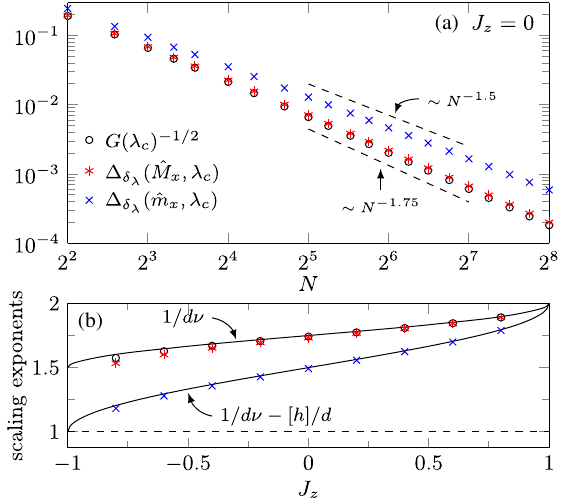
¼ 0 , z=d ¼ 1 and z ˆ M , as described by the x ð ˆ M ; λ ; t Þ ∼ x c λ